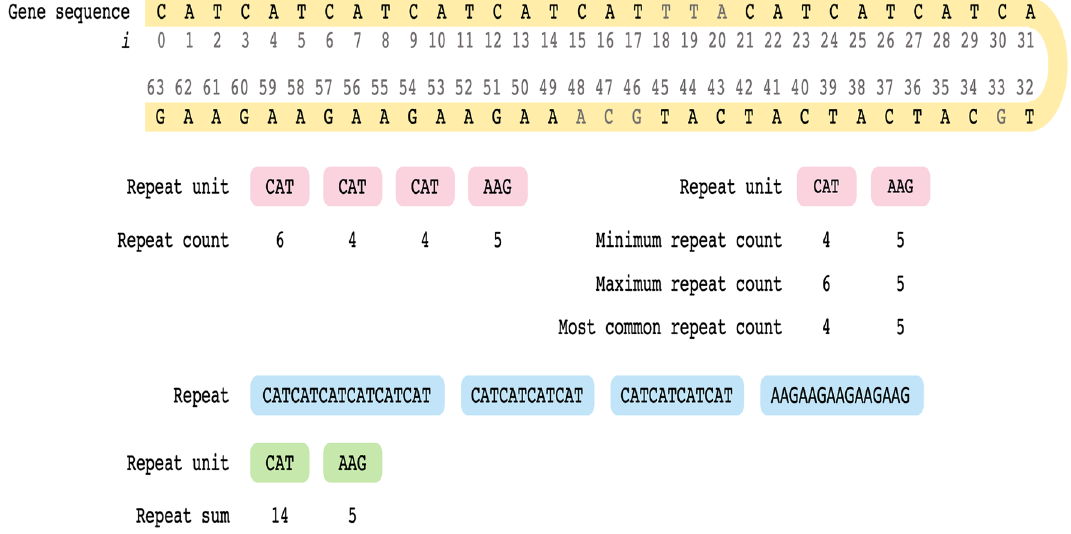
Figure 1. An example using gene sequence to demonstrate the general terminologies used throughout the